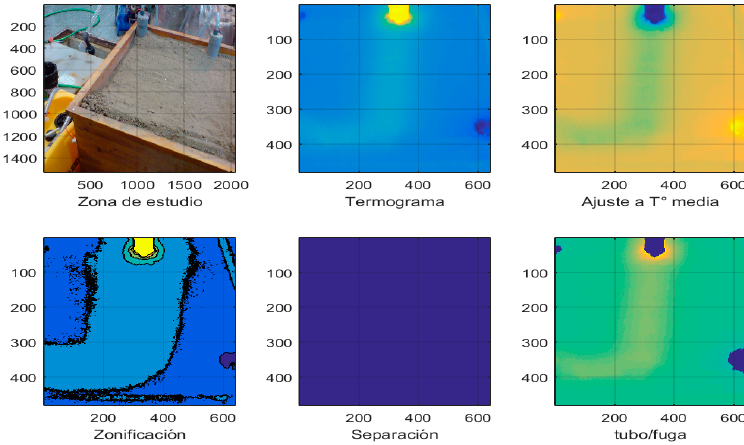
Figure A1. Termogram results with MATLAB algorithms. Test ID: Mr-4.